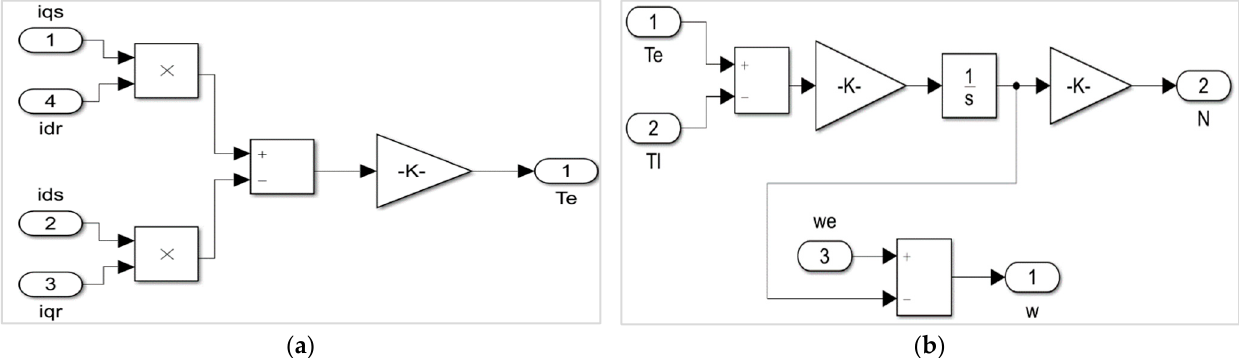
Figure 8. ( a ) Simulation of a dynamic model of an induction motor; ( b ) current equation of the stator.